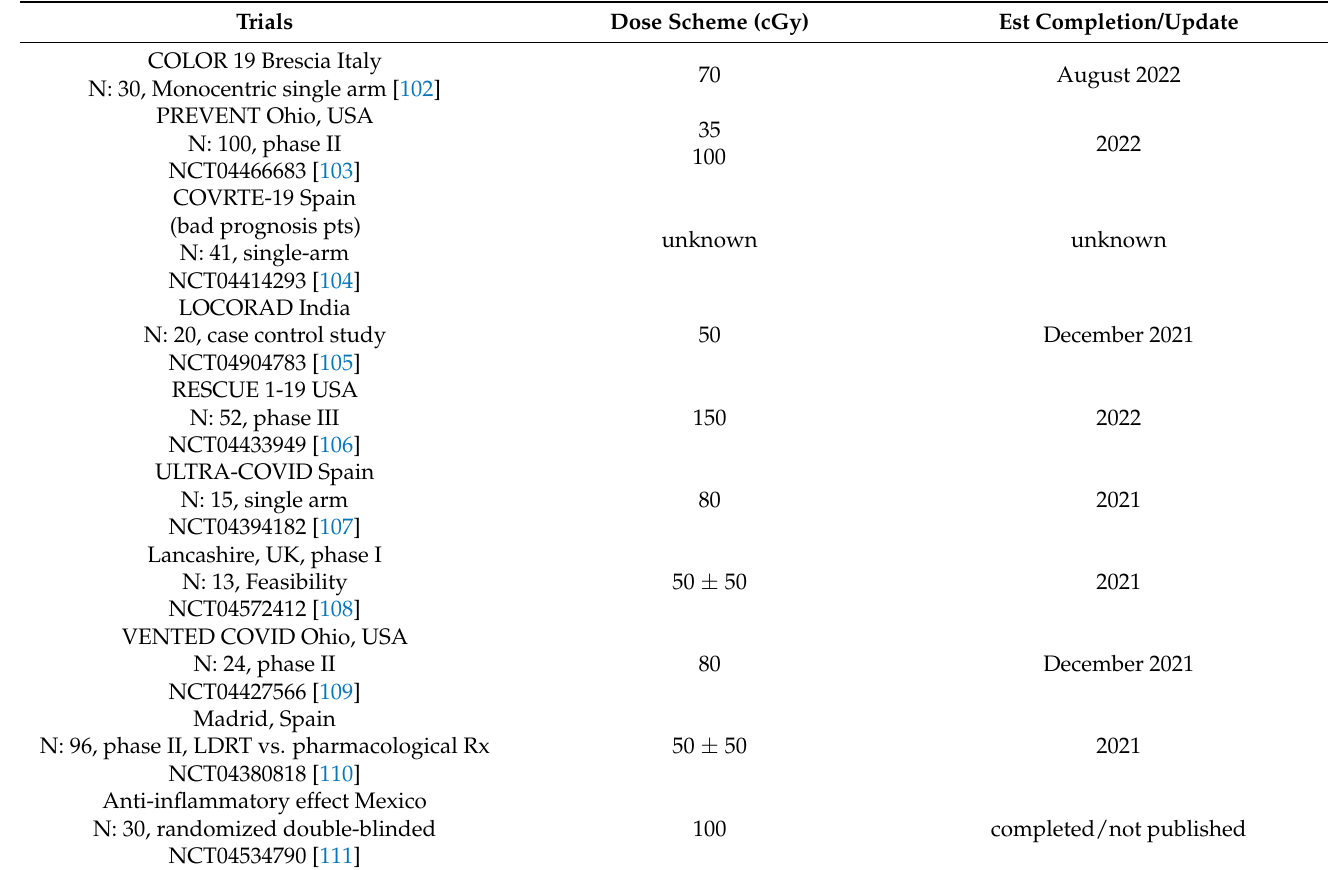
Table A3. LDRT ongoing